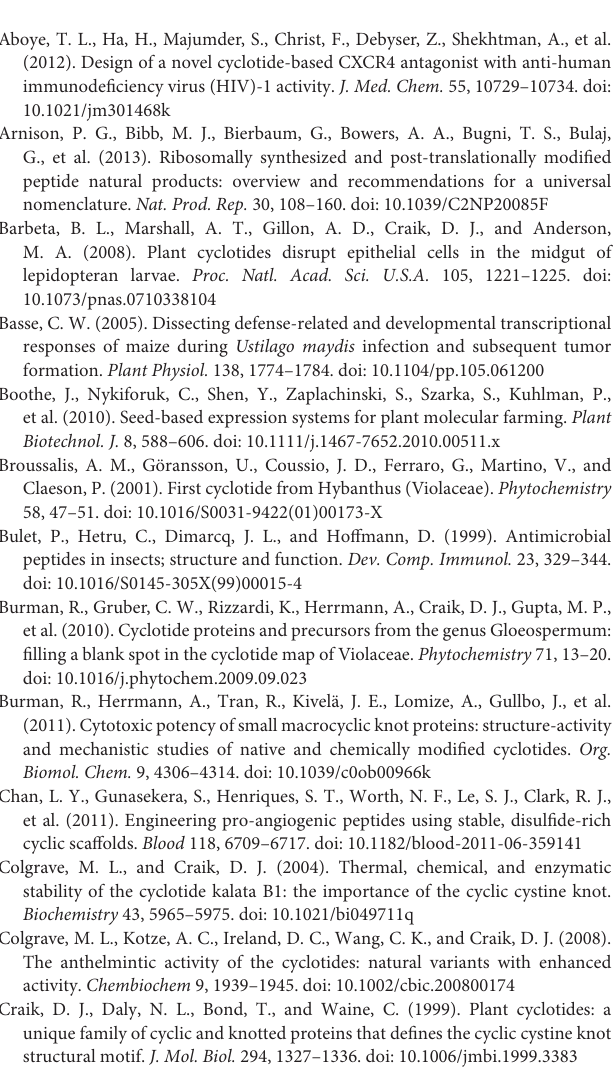
Supplementary Table 1 | Species that contain cyclotides, together with collection data. Supplementary Table 2 | Database of detected cyclotides.